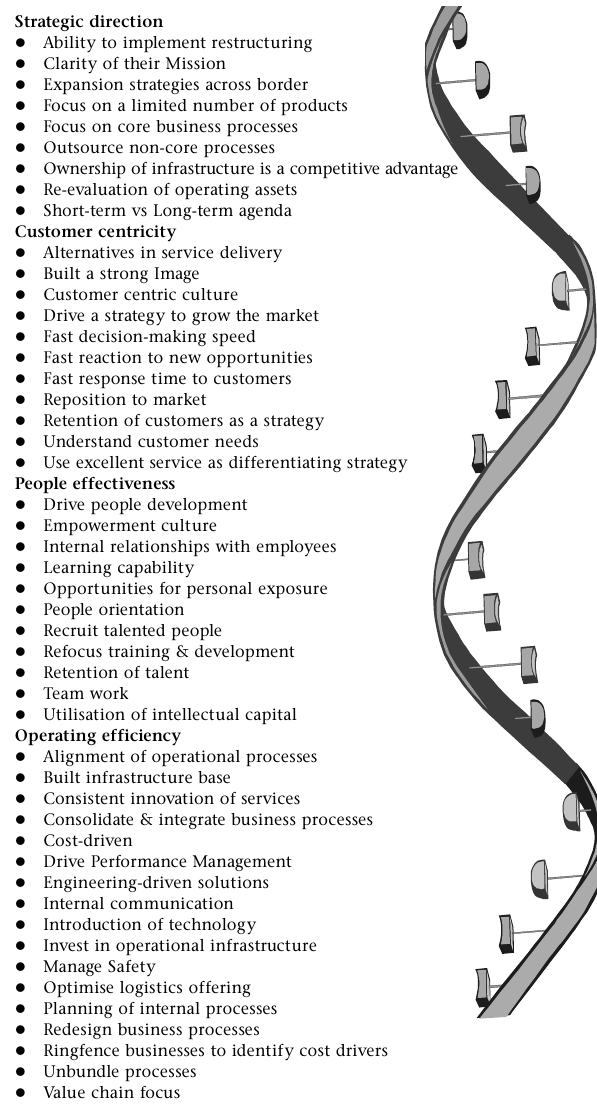
Figure 4: The Organisational Architecture